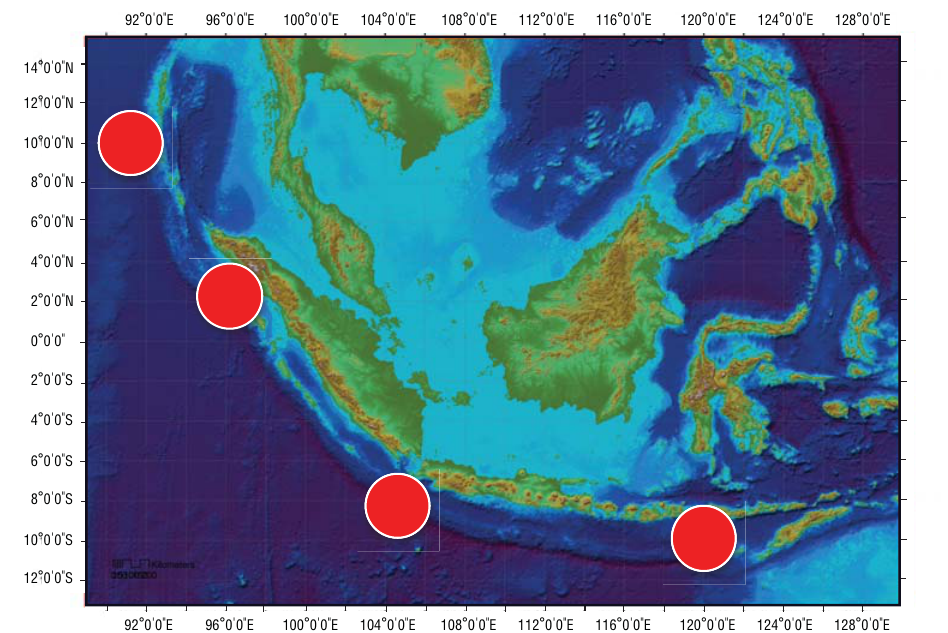
Figure 2. Possible drill sites along the Sunda Arc that represent the transition from collisional tectonics in the east to oblique subduction in the